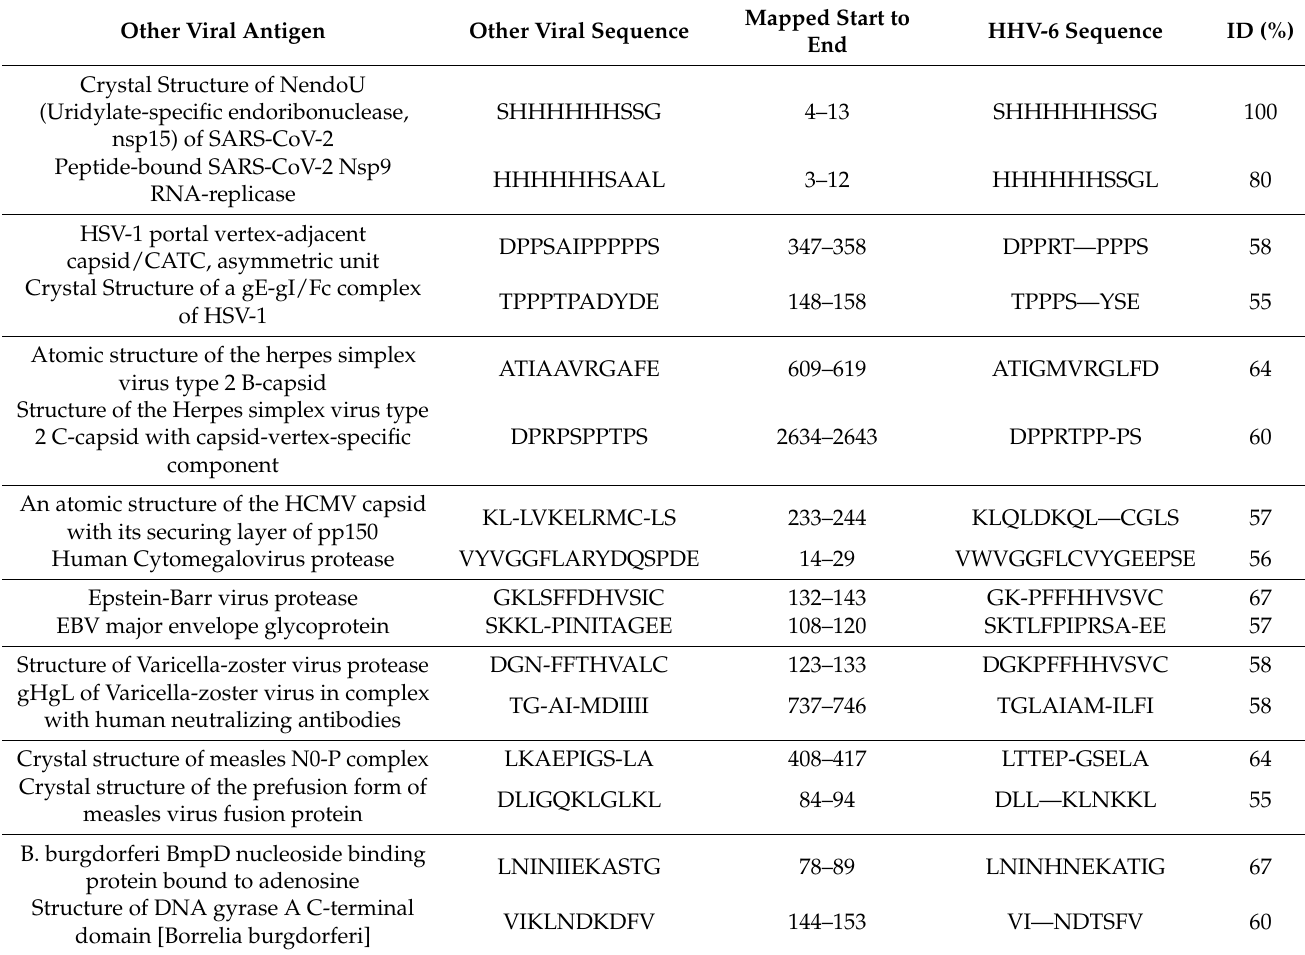
Table 3. Potential cross-reactive epitopes between HHV-6 and other viral